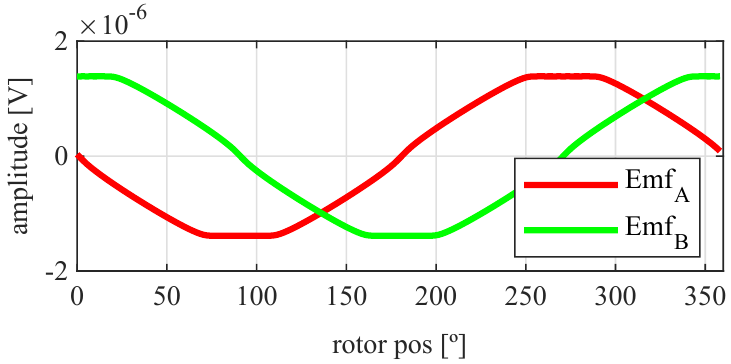
Figure 29. Toroidal slotless resolver EMFs with the least THD.